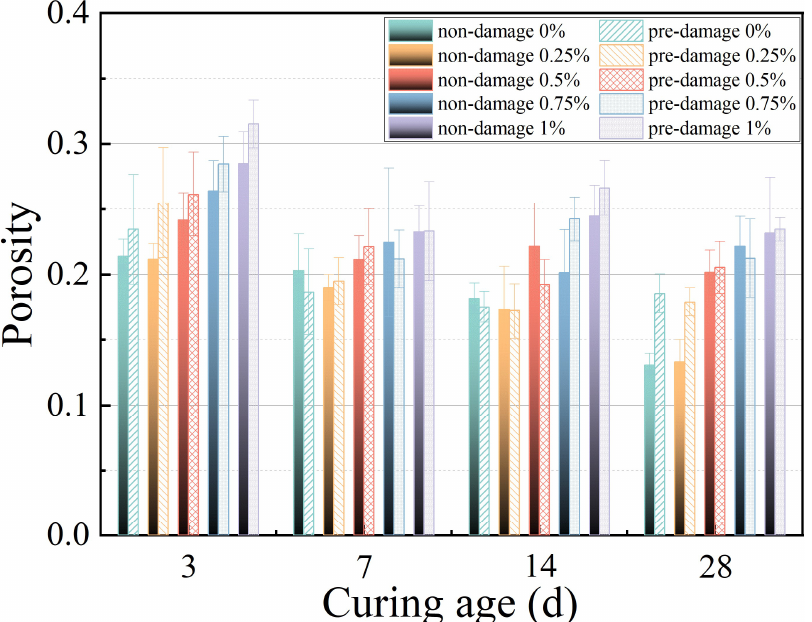
Figure 5. The porosity of samples in non-damage and pre-damage states under a 0.35 W/C ratio, with different ages (3 d, 7 d, 14 d, and 28 d) and SAP components (0%, 0.25%, 0.5%, 0.75%, and 1%).